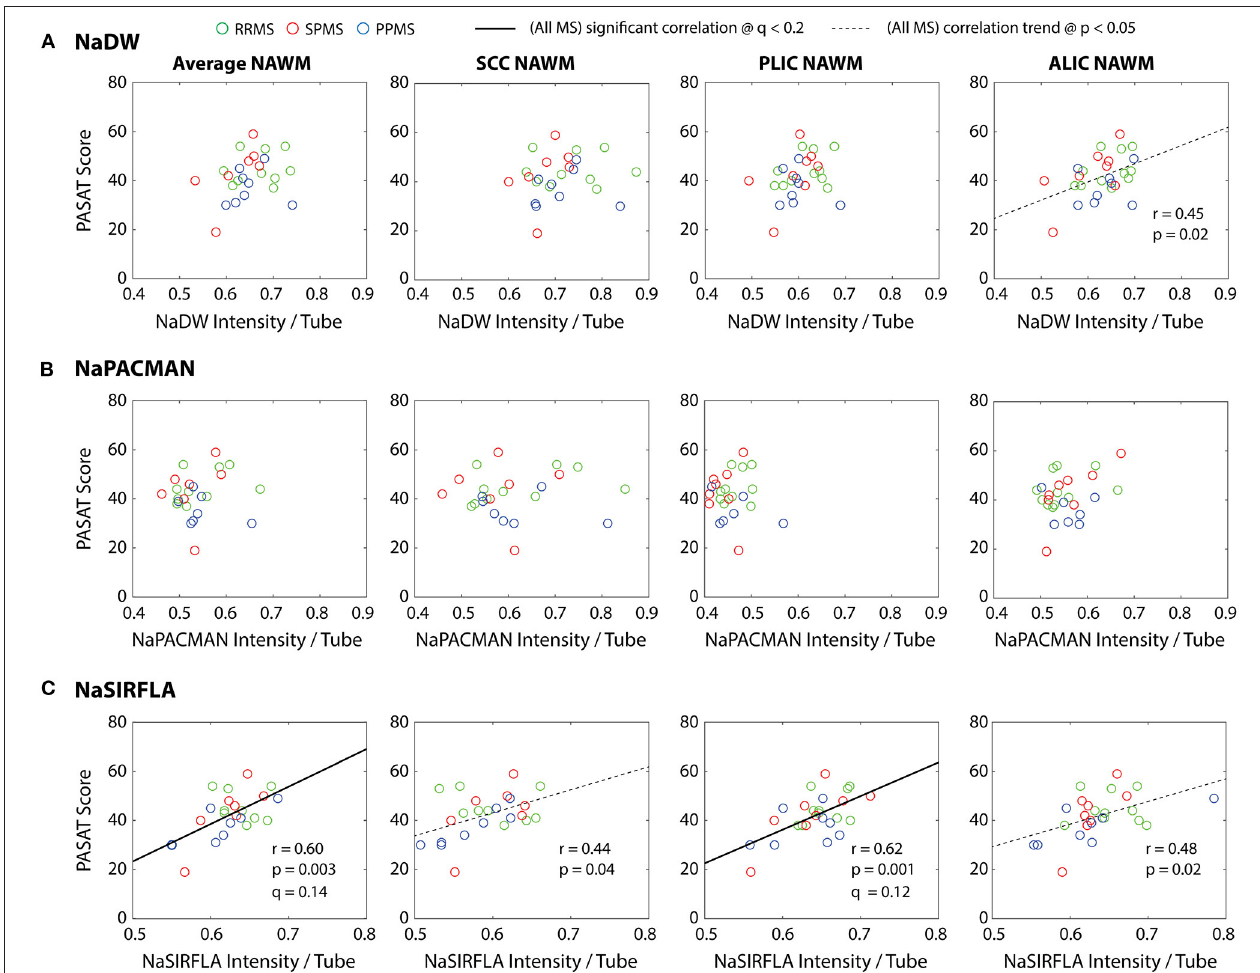
FIGURE 6 | (C) NaSIRFLA in the PLIC NAWM and across the average of all three regions considered significantly correlates positively with PASAT. Similar positive NaSIRFLA trends are observed in both the SCC and ALIC NAWM that do not survive false discovery rate correction. (A) A positive NaDW trend that does not survive false discovery rate correction is also observed in the ALIC NAWM. (B) No correlations or trends were observed for NaPACMAN. Age and sex have little effect on the partial correlation, and thus for display purposes the regression lines shown are those of direct correlation. Note that Na intensity on these three scans did not correlate with the other cognitive and clinical scores (data not